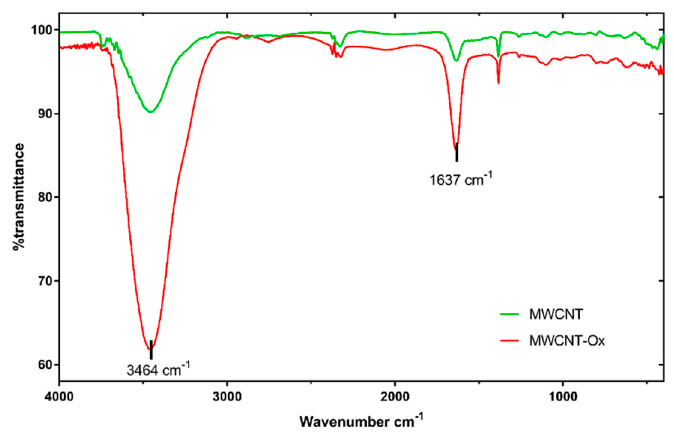
Figure 3. Fourier-transform infrared spectroscopy (FTIR) spectra of pristine MWCNTs and MWCNT- Ox.